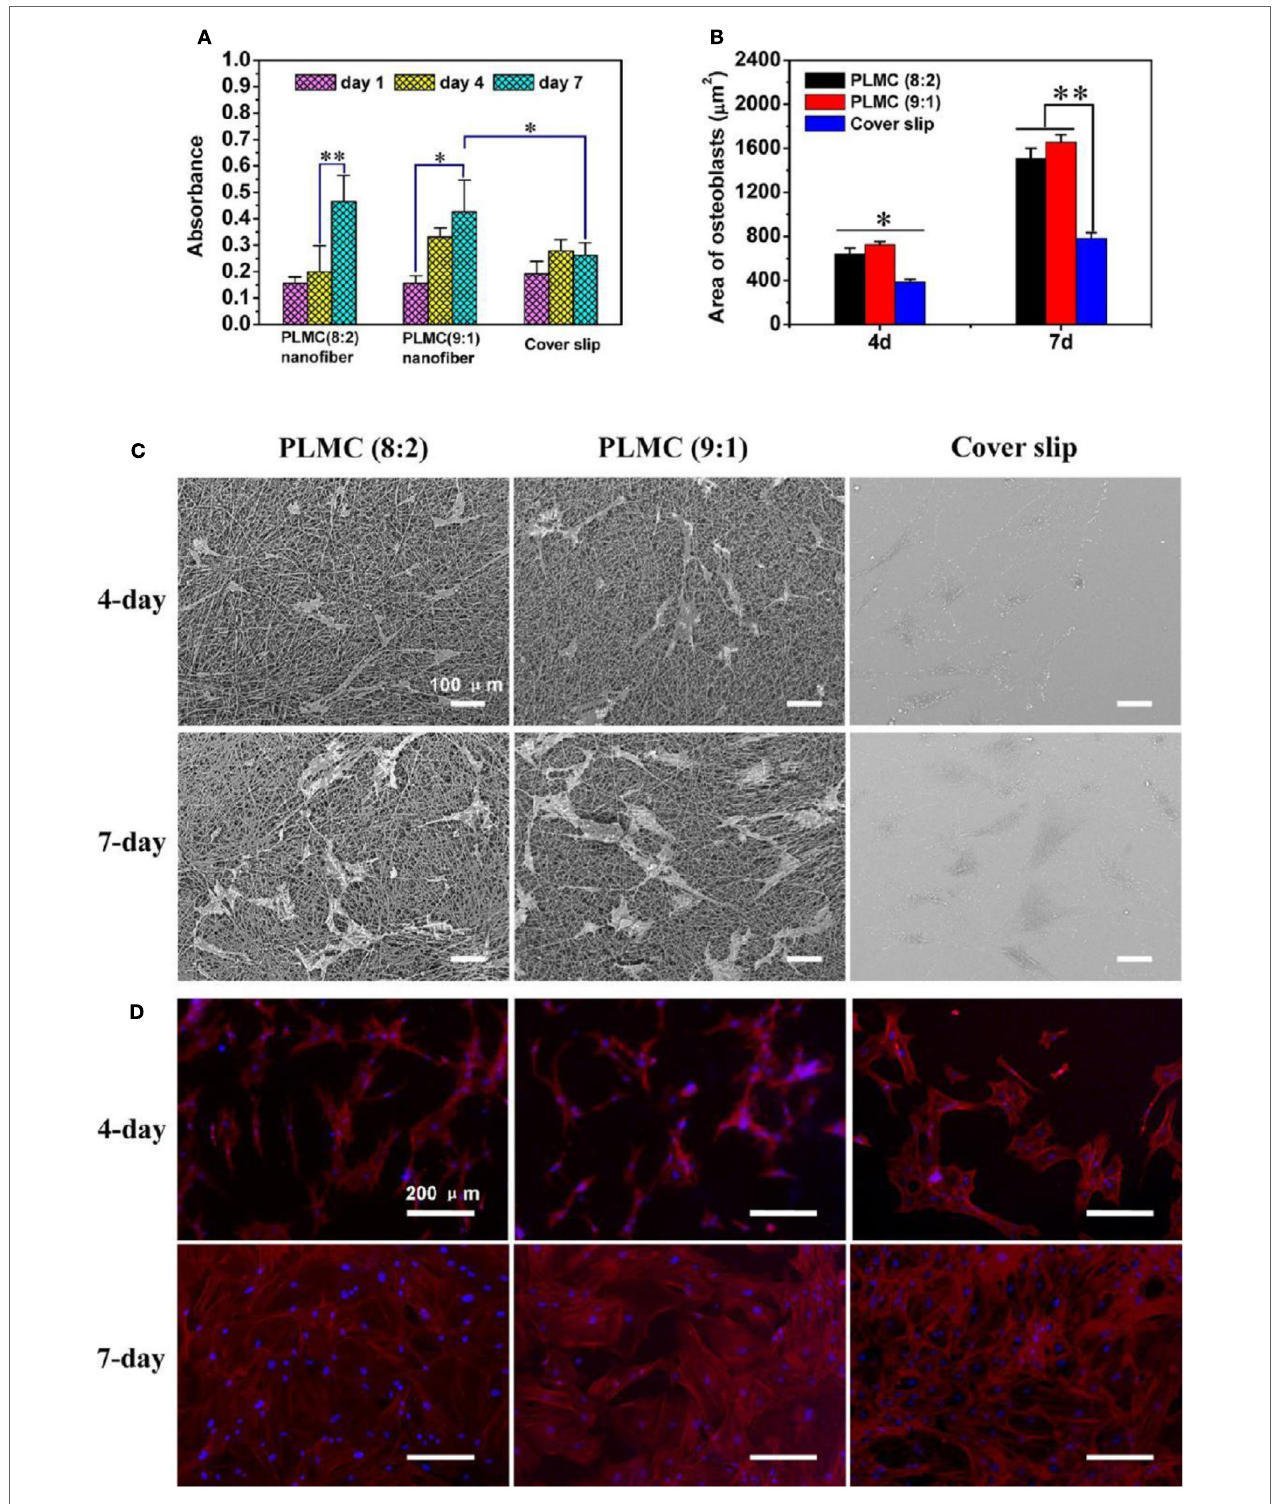
FiGURe 7 | Proliferation and morphology observation of osteoblasts cultured onto the electrospun nanofibrous scaffolds of PLMC (8:2) and PLMC (9:1), and the coverslip control for up to 7 days . (A) Histogram of osteoblast proliferation by MTT assay; (B) histogram of area of osteoblasts; (C) SEM micrographs; (D) fluorescence staining of osteoblasts. F-actin filaments (red) and nucleus (blue) were stained by Phalloidin and DAPI, respectively. Reprinted with permission from Bao et al. (2014). Copyright (2014) American Chemical